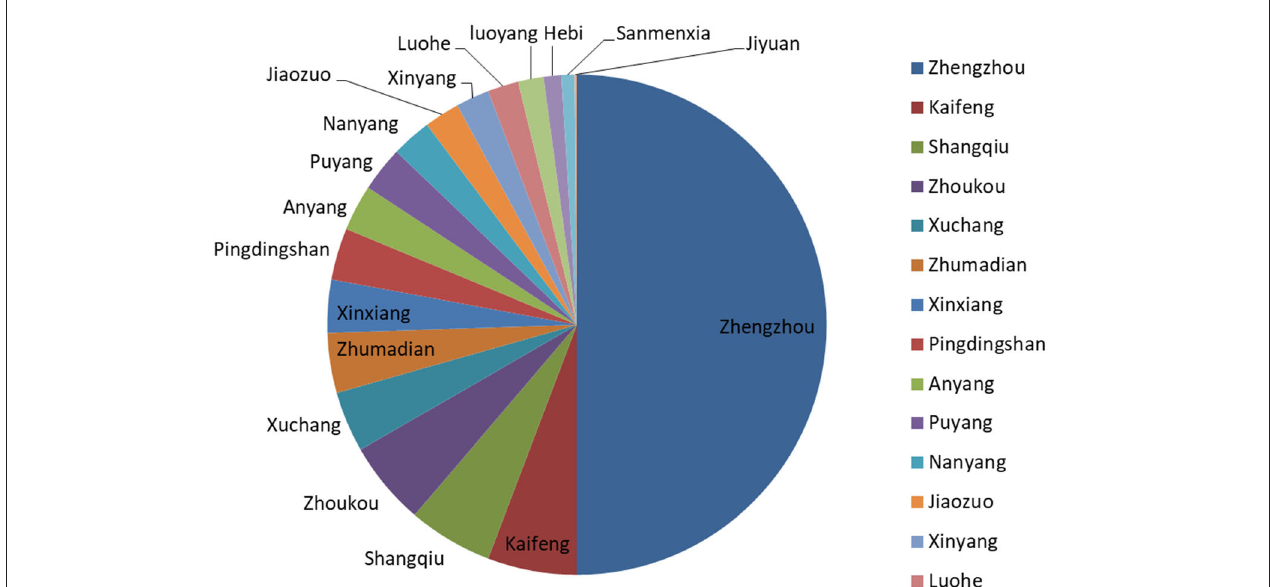
FIGURE 8 | The proportion of users from the cities in Henan Province.